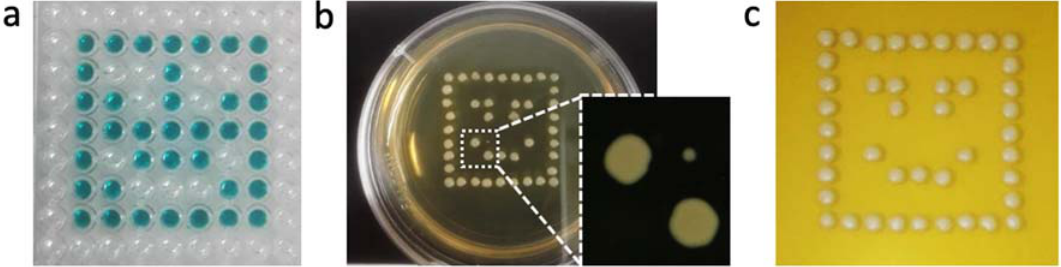
Figure 5. Evaluation of the washing protocol to avoid cross-contamination. ( a ) Printing pattern to evaluate the washing protocol of the piezo dispenser. Transparent wells contain a yeast solution in PBS, and the colored wells contain a blue dye (no cells). ( b ) Washing protocol based on pressure resulted in 1 cross-contamination colony. ( c ) Washing protocol based on the syringe pump resulted in spotting without cross-contamination.